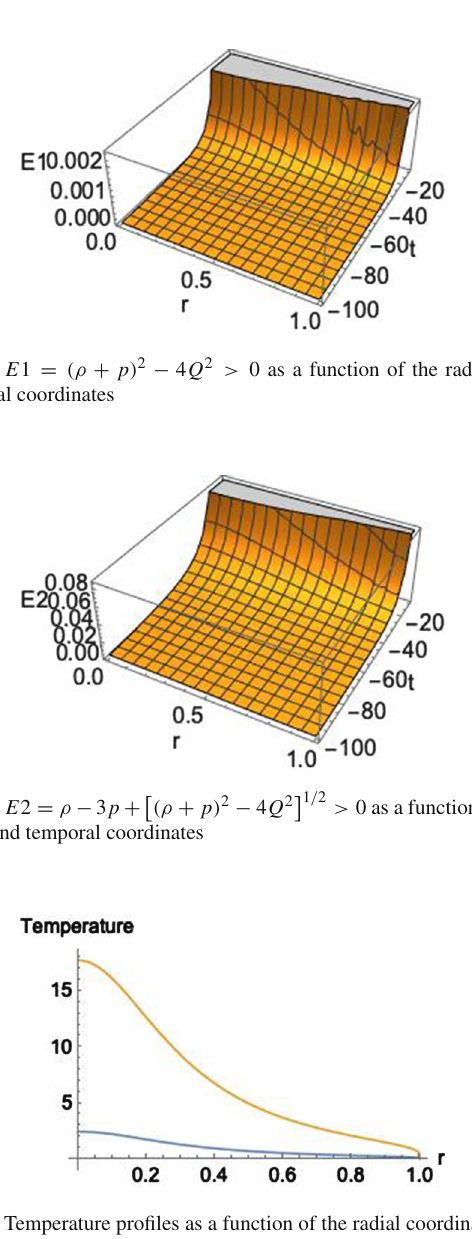
Fig. 7 Temperature profiles as a function of the radial